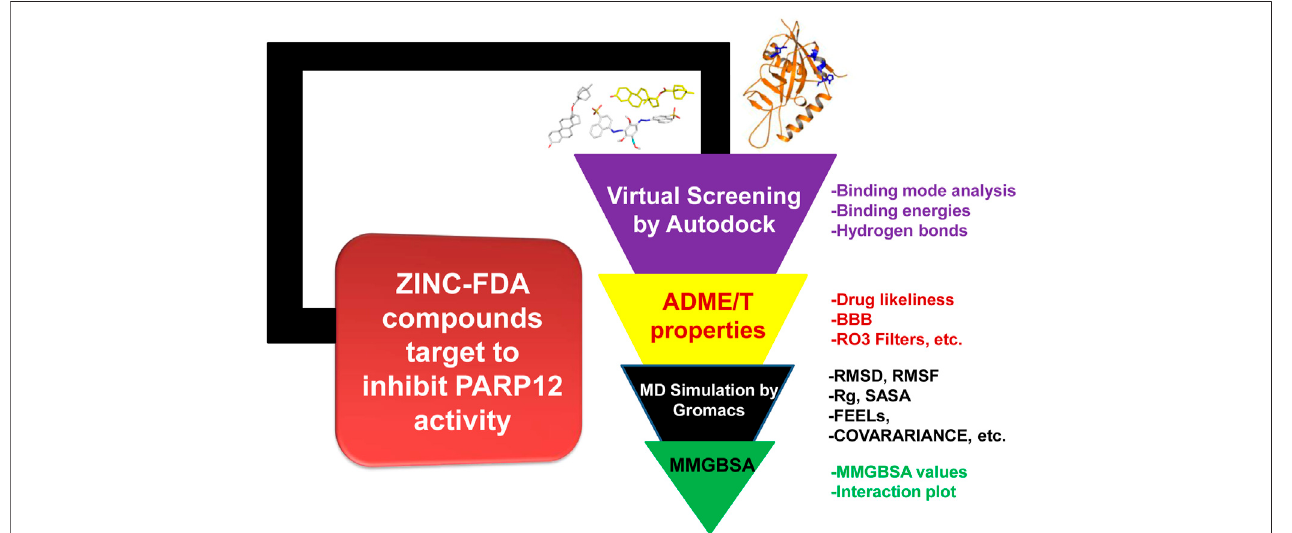
FIGURE 1 | Optimized protocol employed in this